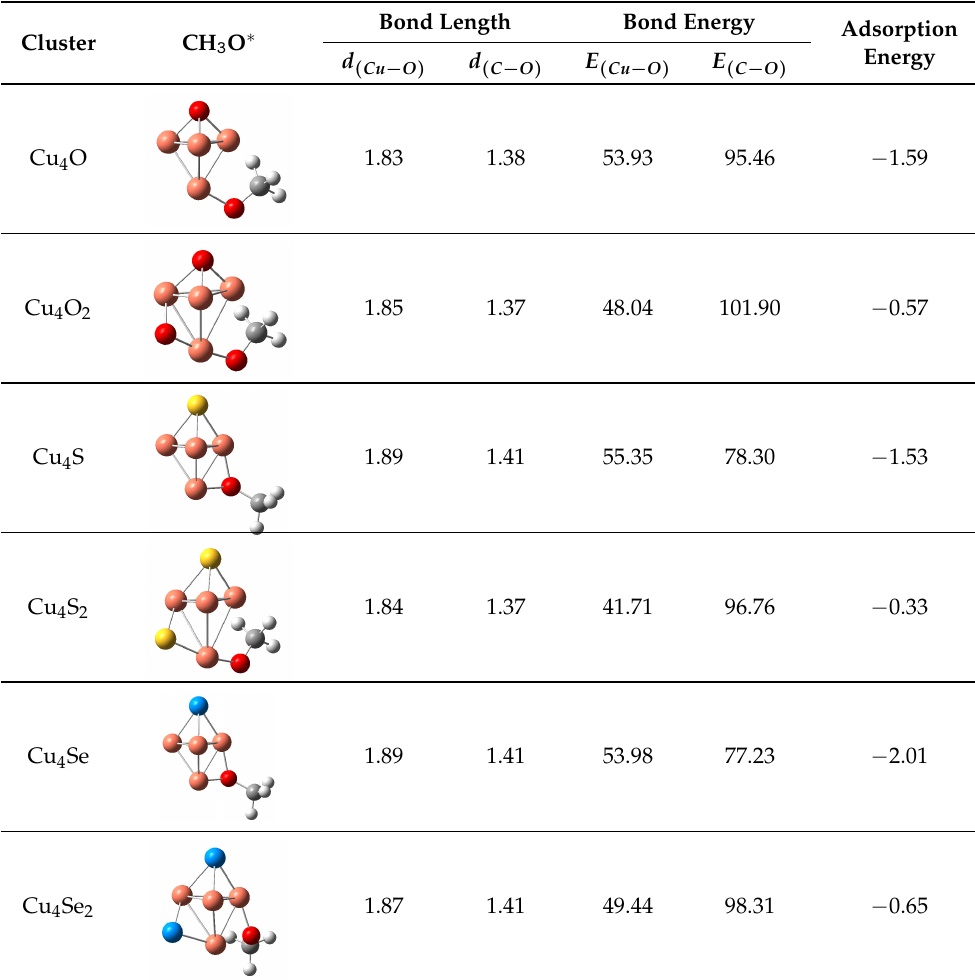
Table 2. The structural details and adsorption energy of intermediate CH 3 O * on Cu 4 X and Cu 4 X 2 (X=O, S, Se)